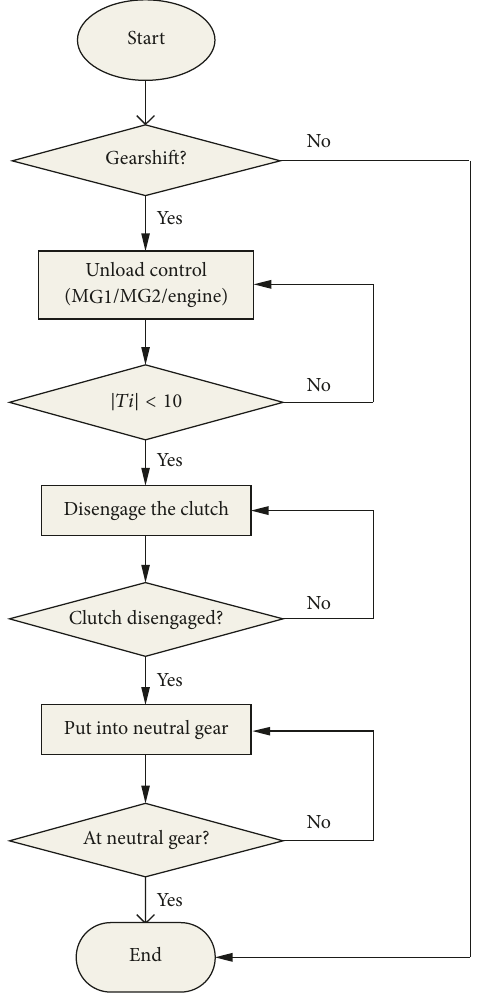
Figure 4: The preparatory phase’s flow